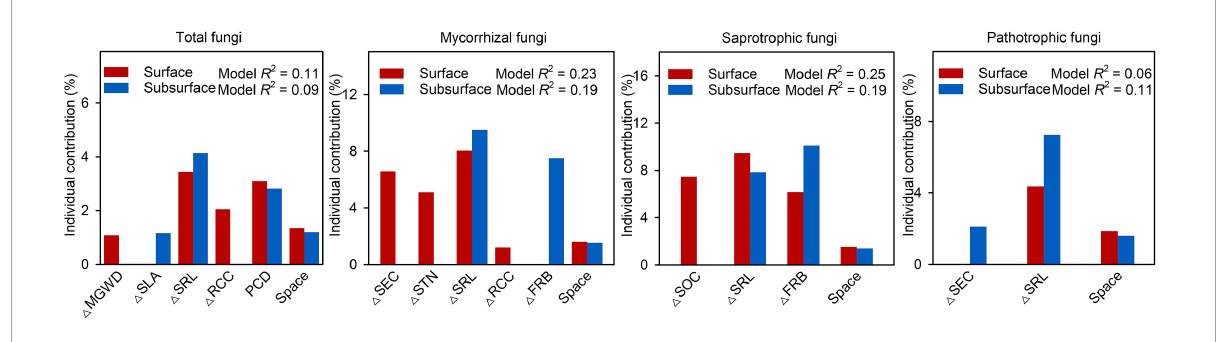
FIGURE3 Results of the multiple regressions on distance matrices (MRM) for β -deviations of total, mycorrhizal, saprotrophic and pathotrophic fungi in surface and subsurface soil. PCD, plant community dissimilarity; SLA, specific leaf area; SRL, specific root length; RCC, root carbon concentration; FRB, fine-root biomass; MGWD, mean groundwater depth; SEC, soil electric conductivity; STN, soil total nitrogen; SOC, soil organic carbon.